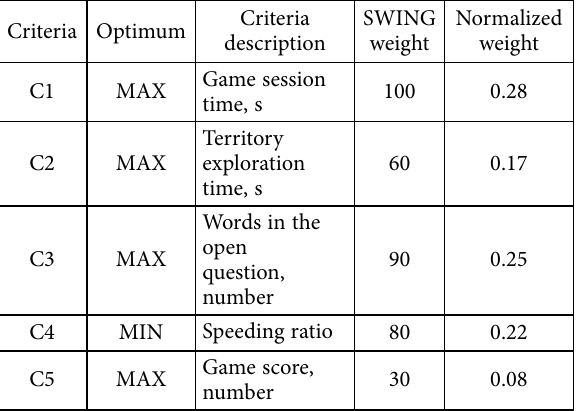
Criteria SWING Normalized description weight weight Game session 100 time, s